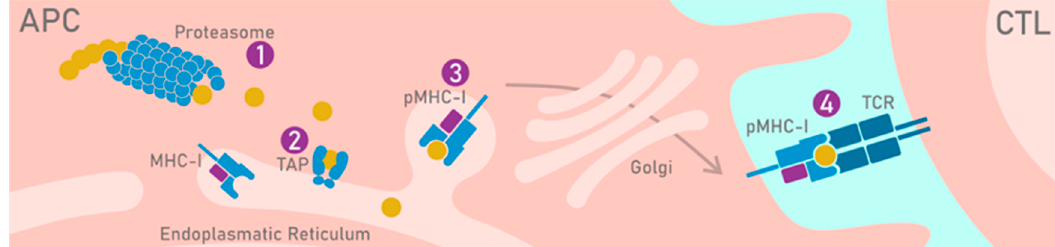
Figure 3. Processing and presentation pathway of HLA-I-restricted peptides. Intracellular proteins are processed by a proteasome (1). This cleavage determines the C-terminus of the peptides. The peptides bind transporter-associated antigen processing (TAP) that transports them into the endoplasmic reticulum (ER) (2). The peptides bind the HLA molecule that forms the pHLA complex (3) that is transported via the Golgi on the cell surface where CD8+ T cells can recognize them (4).